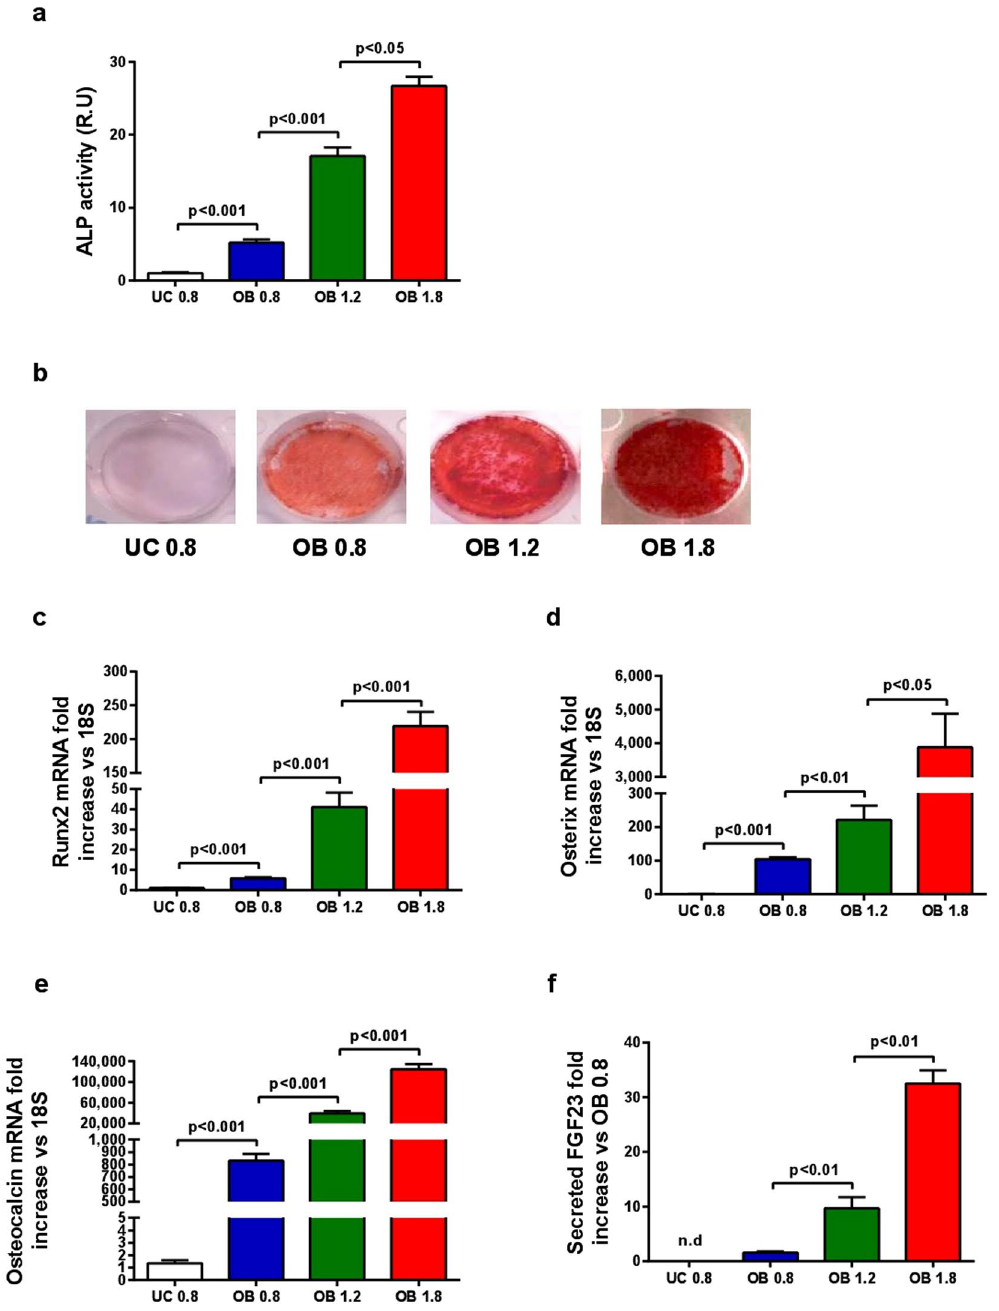
Figure 1. Effects of MgCl 2 supplementation on osteogenesis and mineralization of rat MSC. ( a ) ALP activity was significantly and dose-dependently increased by Mg 2 + concentration. ( b ) Matrix mineralization verified by Alizarin Red S staining was higher according to Mg 2 + levels. ( c ) Osteogenic marker genes Runx2, ( d ) Osterix and ( e ) Osteocalcin expression was up-regulated according to the increase in Mg 2 + concentrations. ( f ) Intact FGF23 in the liquid supernatant was increased according to Mg 2 + concentrations. FGF23 was not detected in liquid supernatant of UC. UC - undifferentiated cells, OB - osteoblasts. Bars show mean ± SEM. n =